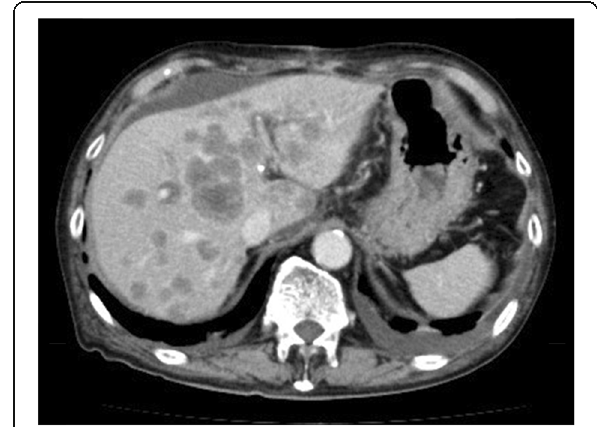
Fig. 3 Multiple liver metastases and ascites on the liver surface were observed by CT (axial section image) 1 month after surgery